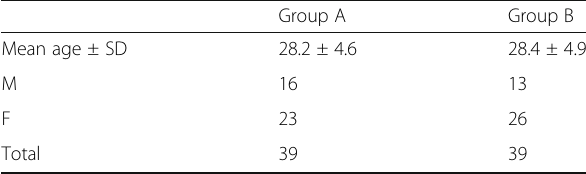
Table 1 The demographic data for both